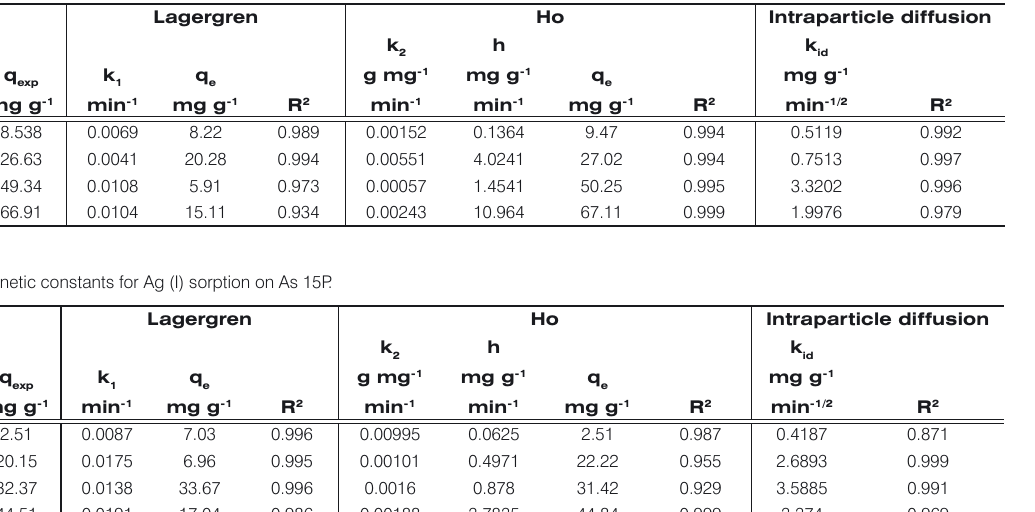
Table 6. Kinetic constants for Ag(I) sorption on As 14P.